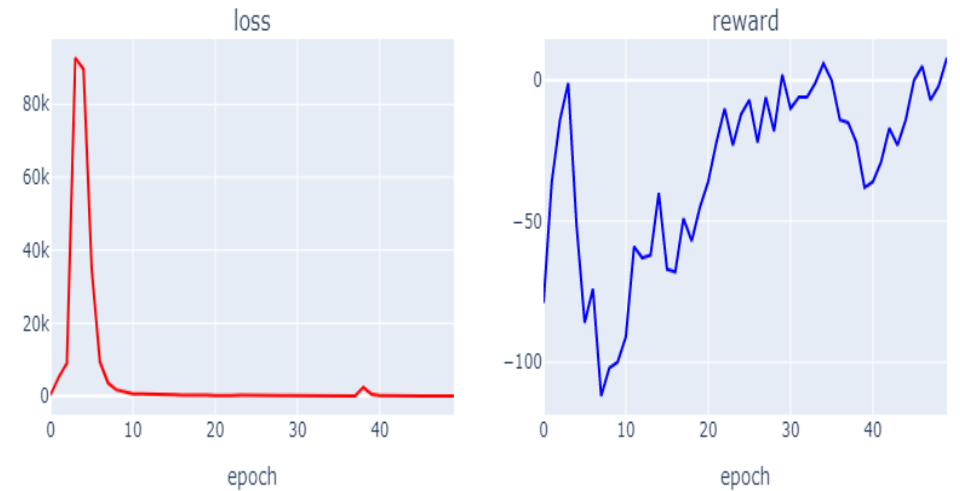
Figure 6. Learning results by substituting the DQN algorithm based on the proposed Total Resource on